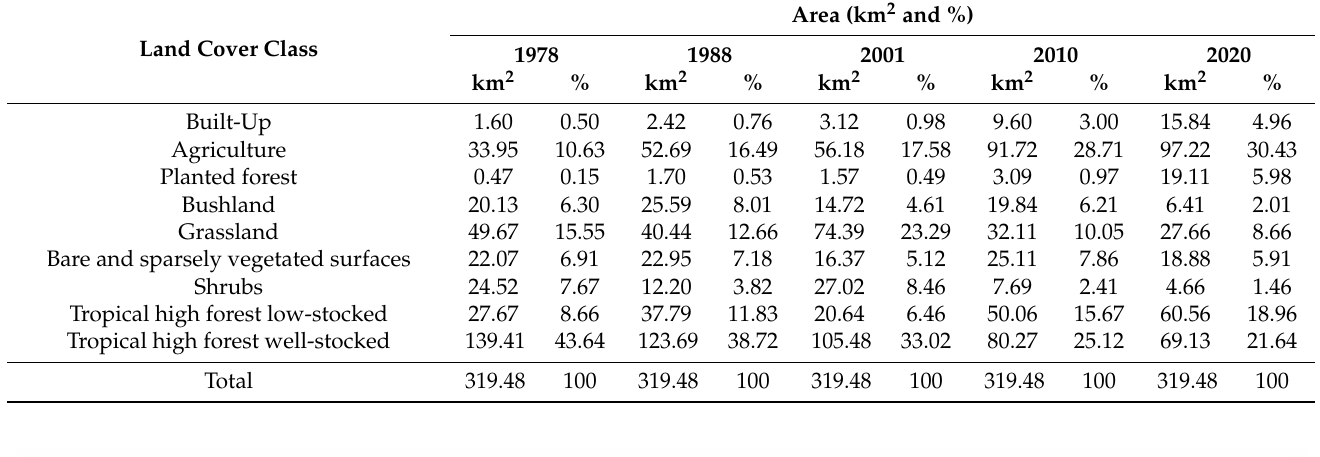
Table 4. The area coverage (km 2 and percentage) of different land cover categories in the upper Manafwa watershed during 1978, 1988, 2001, 2010, and 2020.